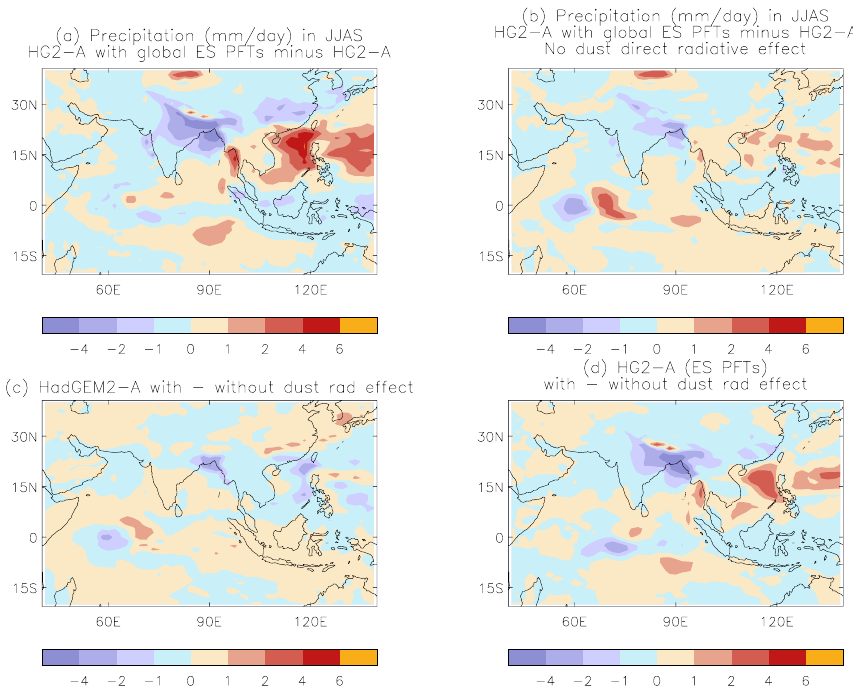
Fig. 8. Changes in JJAS precipitation between (a) HadGEM2-A and -AE experiments, (b) as (a) but without the direct radiative effect of dust, (c) HadGEM2-A with-without direct radiative effect of dust, (d) as (c) but for HadGEM2-AE.